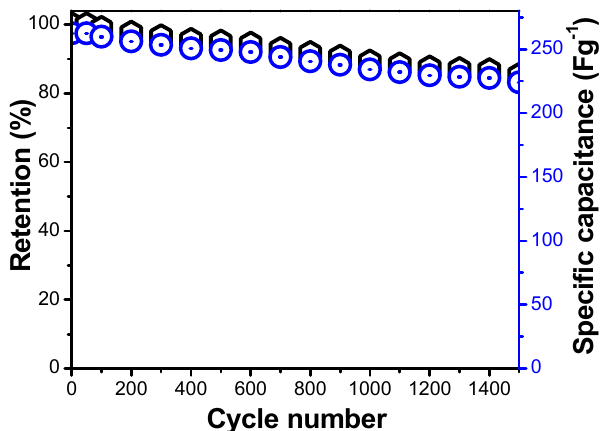
Figure 12. Cyclic performance of the percent of Ni-Ti-3 LDHs in terms of retention and specific capacitance.